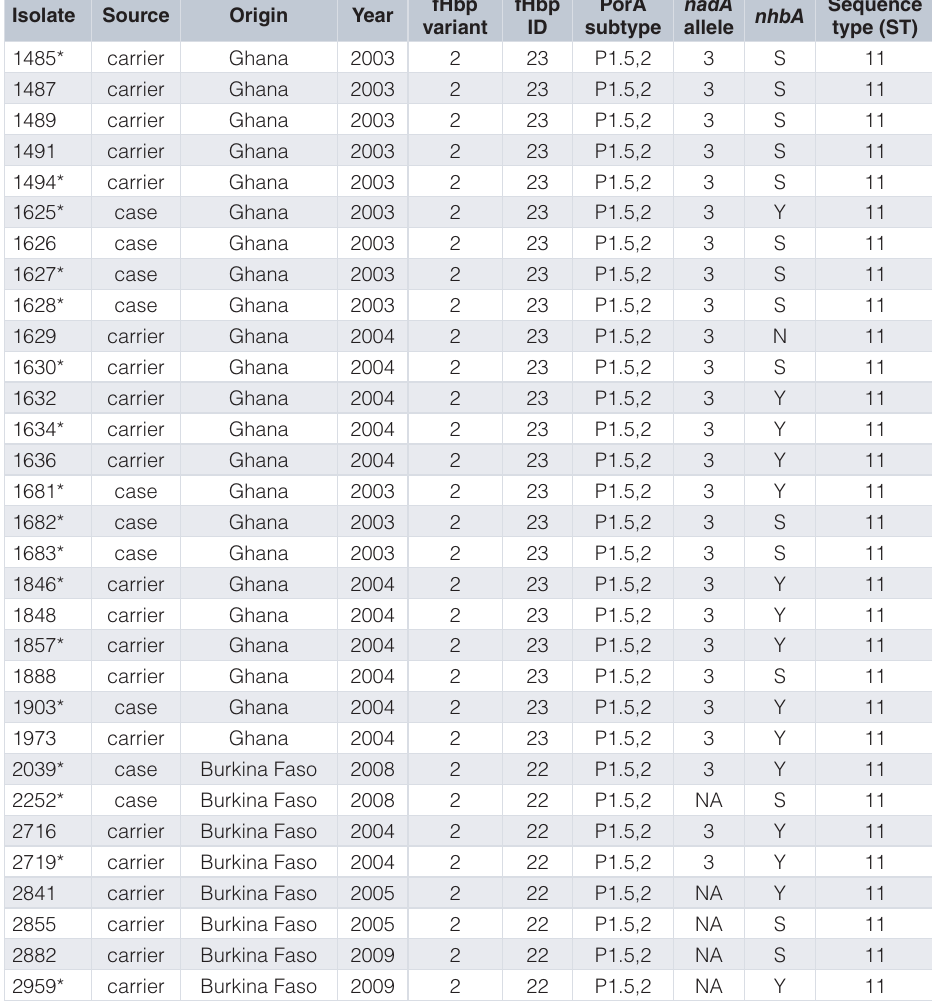
Table 1. Characteristics of serogroup W isolates used in this study. Molecular characterization was performed on these isolates by PCR amplification and sequencing of fHbp, porA, nadA and nhbA . Isolate